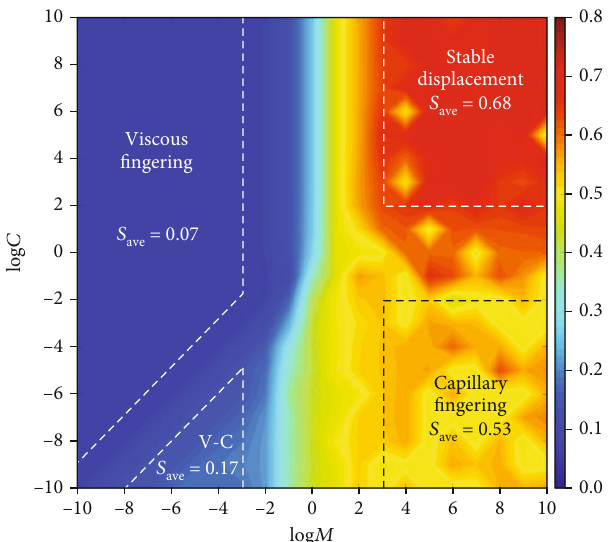
Figure 5: E ff ects of the viscosity ratio and capillary number on the displacement e ffi ciency for the original tube network model ( σ = σ and cn = 8 : 0